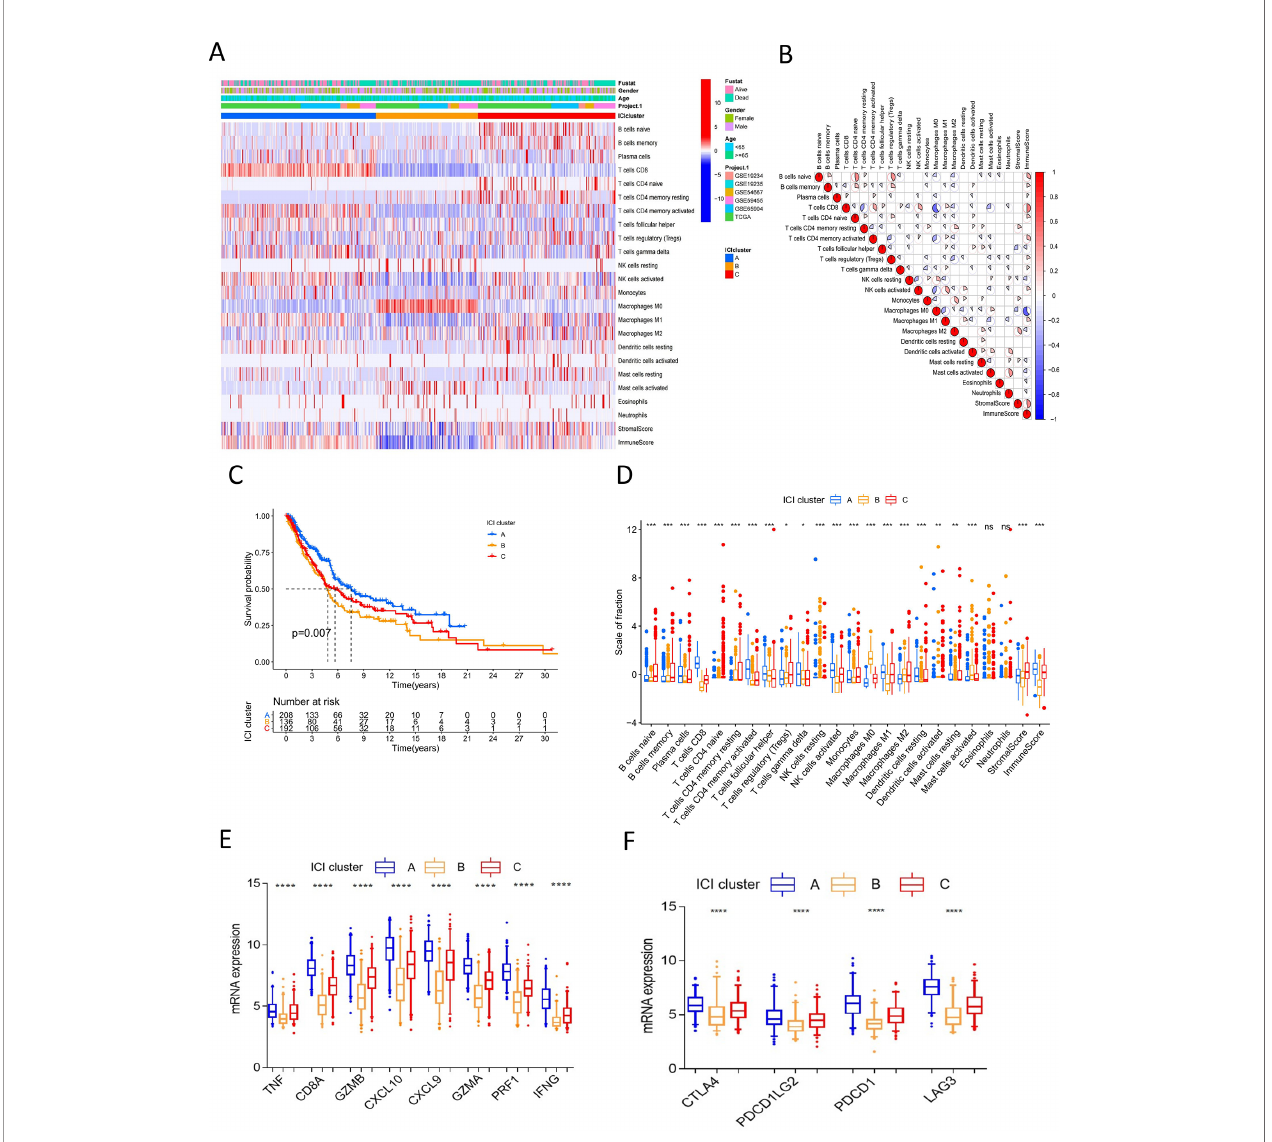
FIGURE 1 | Landscape of immune cells in fi ltration in melanoma. (A) Unsupervised clustering heatmap of immune cells in fi ltration for all melanoma samples. Rows represent tumor-in fi ltrating immune cells, and columns represent samples. (B) The correlation coef fi cient heatmap of immune cell interaction. (C) Kaplan-Meier curves of overall survival for ICI cluster A – C. Log rank test P = 0.007. (D) The box plot of immune cells fraction in ICI cluster A – C. *P<0.05; **P < 0.01; ***P<0.001; ****P<0.0001; ns: no signi fi cance. (E) The box plot of immune activity related signature genes expression (CXCL9, CXCL10, TNF, IFNG, CD8A, GZMA, GZMB, PRF1) between ICI cluster A – C, ****P<0.0001. (F) The box plot of immune checkpoint signature genes expression (CTLA4, PDCD1, PDCD1LG2, LAG3) between ICI cluster A-C,